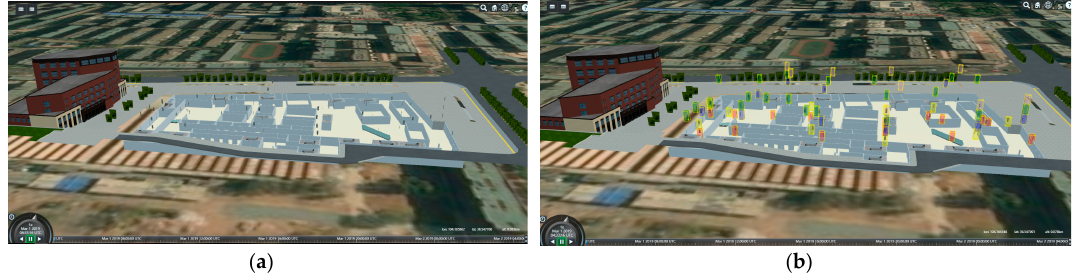
Figure 14. ( a ) Segmented model. The position of the internal hydrant parts can be clearly seen. ( b ) Fire hydrant parts coding. Three-dimensional grids of different colors represent the hydrant parts on different floors.